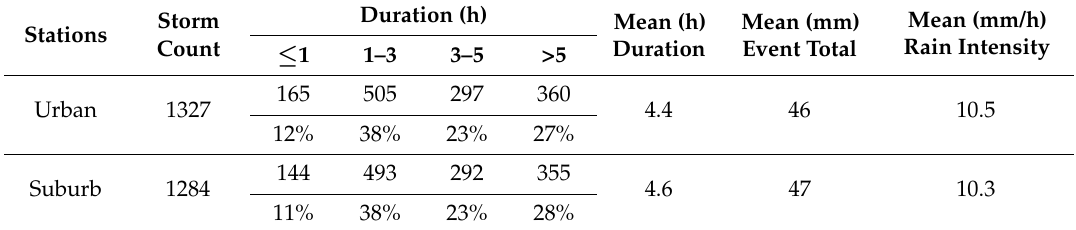
Table 1. Statistics of storm events at Sites 1–6 for the hourly rainfall data from 1990 to 2017.